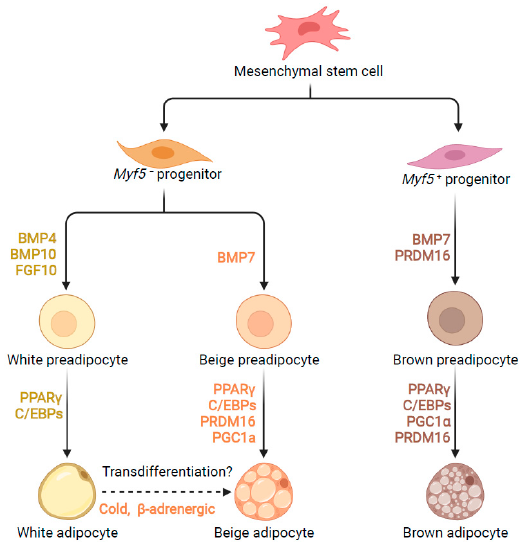
Figure 1. Transcriptional control of adipogenesis. All types of adipocytes are derived from mesoderm mesenchymal stem cells, which contain Myf5 − and Myf5 + cell lineage. FGF10, BMP4, and BMP10 stimulate Myf5 − cell commitment to white pre-adipocyte, while BMP7 triggers Myf5 − cell commitment to beige adipocyte. BMP7 and PRDM16 induce Myf5 + cell commitment to brown pre- adipocyte. PPAR γ and C/EBPs play key roles in all types of adipocyte differentiation. Brown and beige adipogenesis require the expression of additional proteins, including Prdm16 and Pgc1 α . In addition, beige adipocytes may also come from transdifferentiation of white adipocytes under cold exposure or β -adrenergic stimulation.